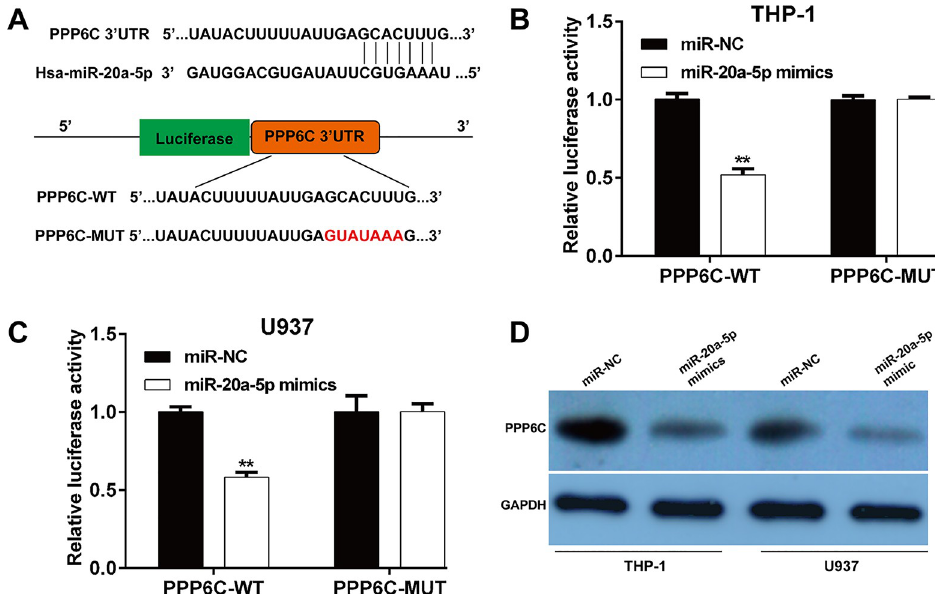
Fig 3. MiR-20a-5p negatively regulated PPP6C expression by targeting its 3’UTR. (A) The complementary sequences between wild-type or mutant human PPP6C 3’-UTRs mRNA and human miR-20a-5p . (B) THP-1 and (C) U937 cells were co-transfected with miR-20a-5p mimics or miR-NC and the luciferase reporter construct containing the wild-type or mutant PPP6C 3 0 -UTR. For each experiment, the results were normalized to the luciferase activity detected in the cells transfected with the control vector. Data are presented as mean ± SD of three independent experiments. �� p < 0.01, compared with miR-NC; (D) The expression of PPP6C protein was detected in THP-1 and U937 cells after transfection with miR-20a-5p mimics or miR-NC.